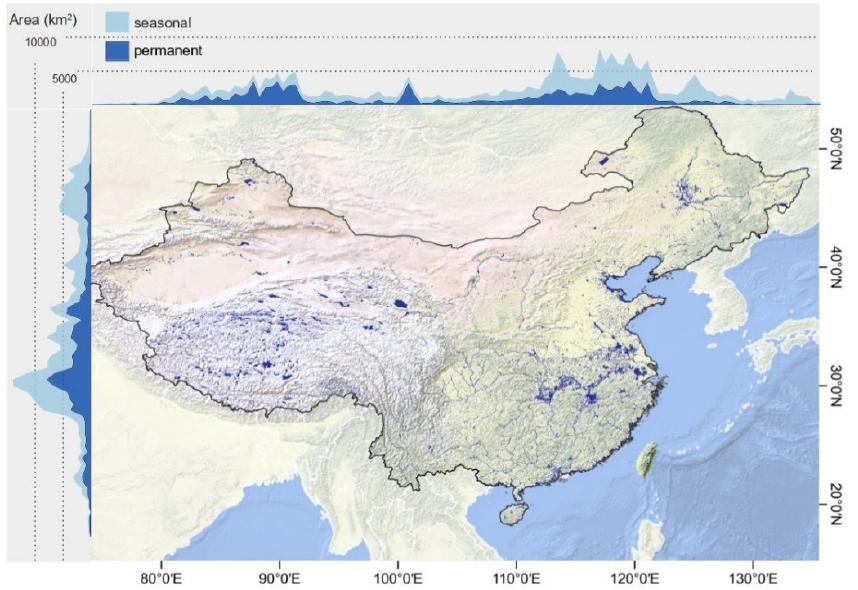
Figure 3. Maximum surface water extent in mainland China, and permanent and seasonal water summarized in zones of 0.5 degree latitude/longitude.